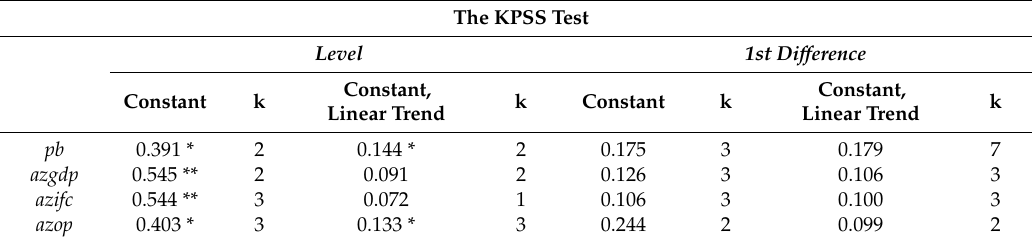
Table A13. AZ. The Unit Root test results.